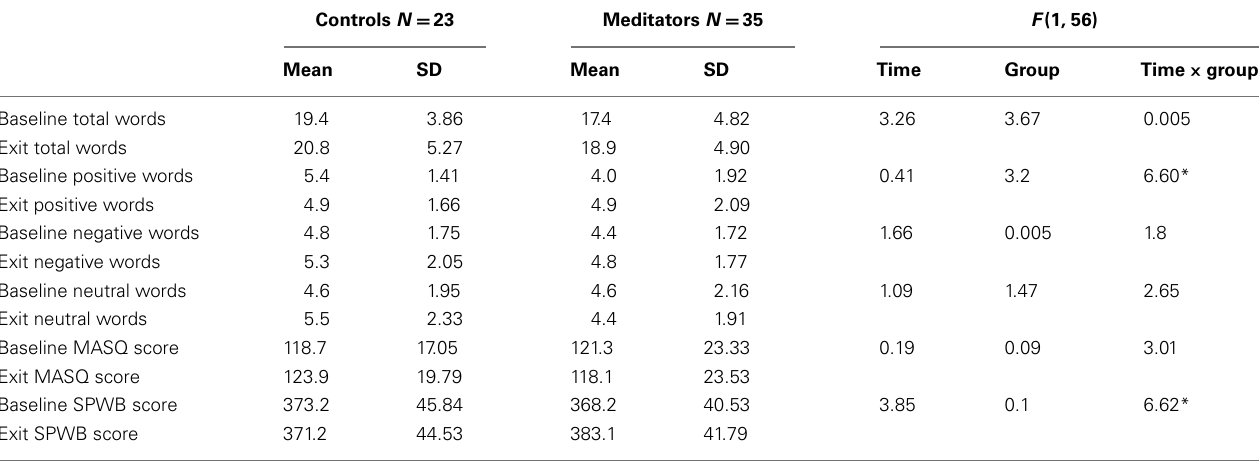
Table 1 | Mean (SD) of word recall and self-report measures before and after training in meditators and